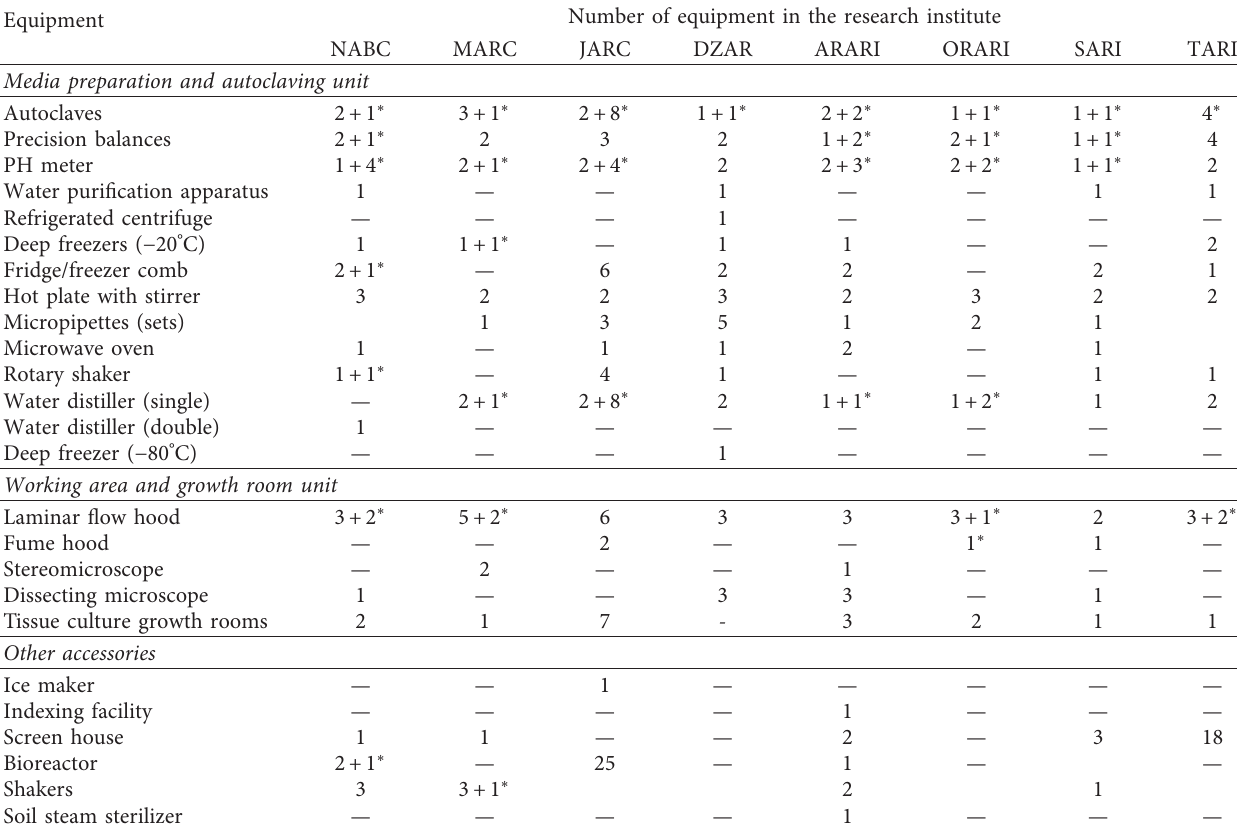
Table 1: List of basic equipment available in plant tissue culture laboratories at Ethiopian agricultural research institutes.